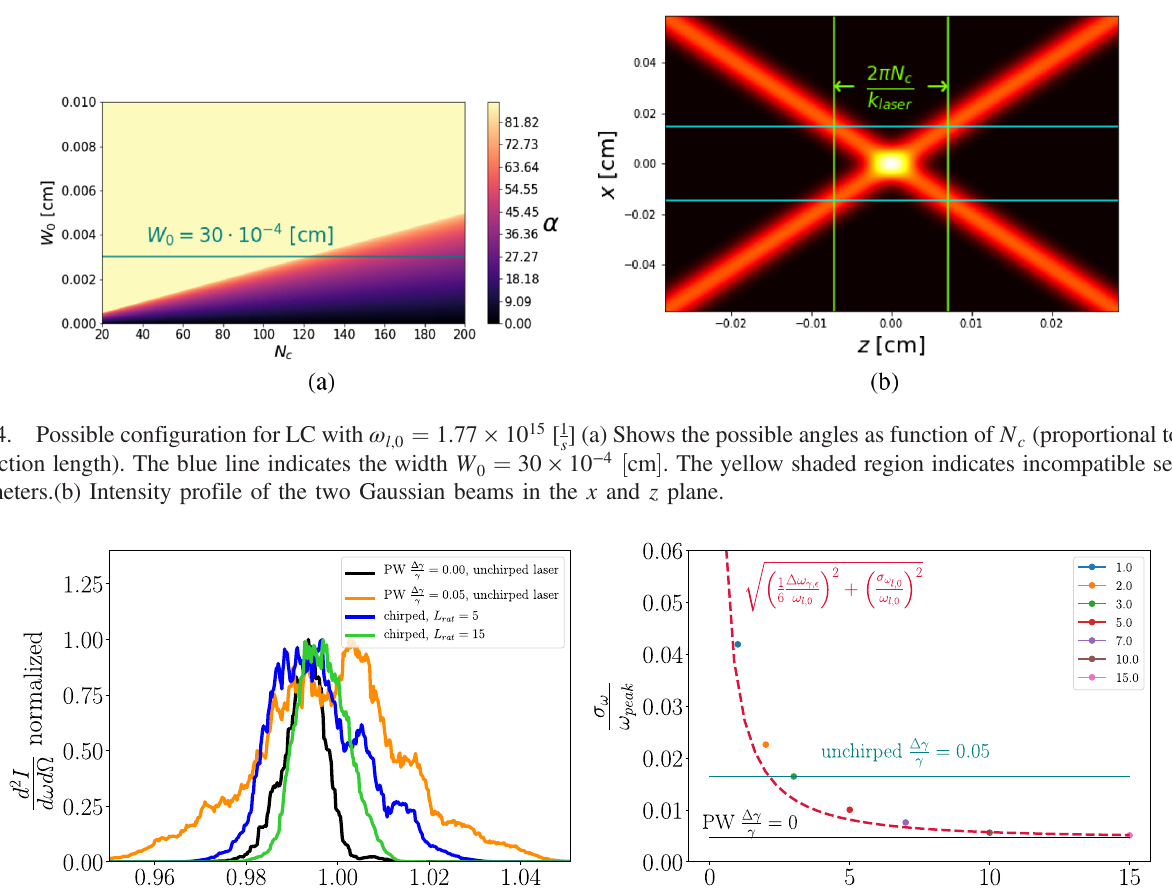
] parameters, a 0 ¼ 10 − 1 , N c ¼ 150 , s ¼ 10 3 , σ ¼ 15 × 10 − 4 ½ cm (cid:2) , σ ¼ 15 . 75 × 10 − 4 ½ cm (cid:2) , e x;y z ¼ 0 . 05 linear in ˆ z and no initial transverse momentum. Left: spectra for the electrons colliding γ . Equation (23) predicts accurately the rat Δ ω γ ; ϵ ¼ 0 . 05 the for is for the conversion from full bandwidth to rms values. For the Δ γ 6 ω l; 0 γ